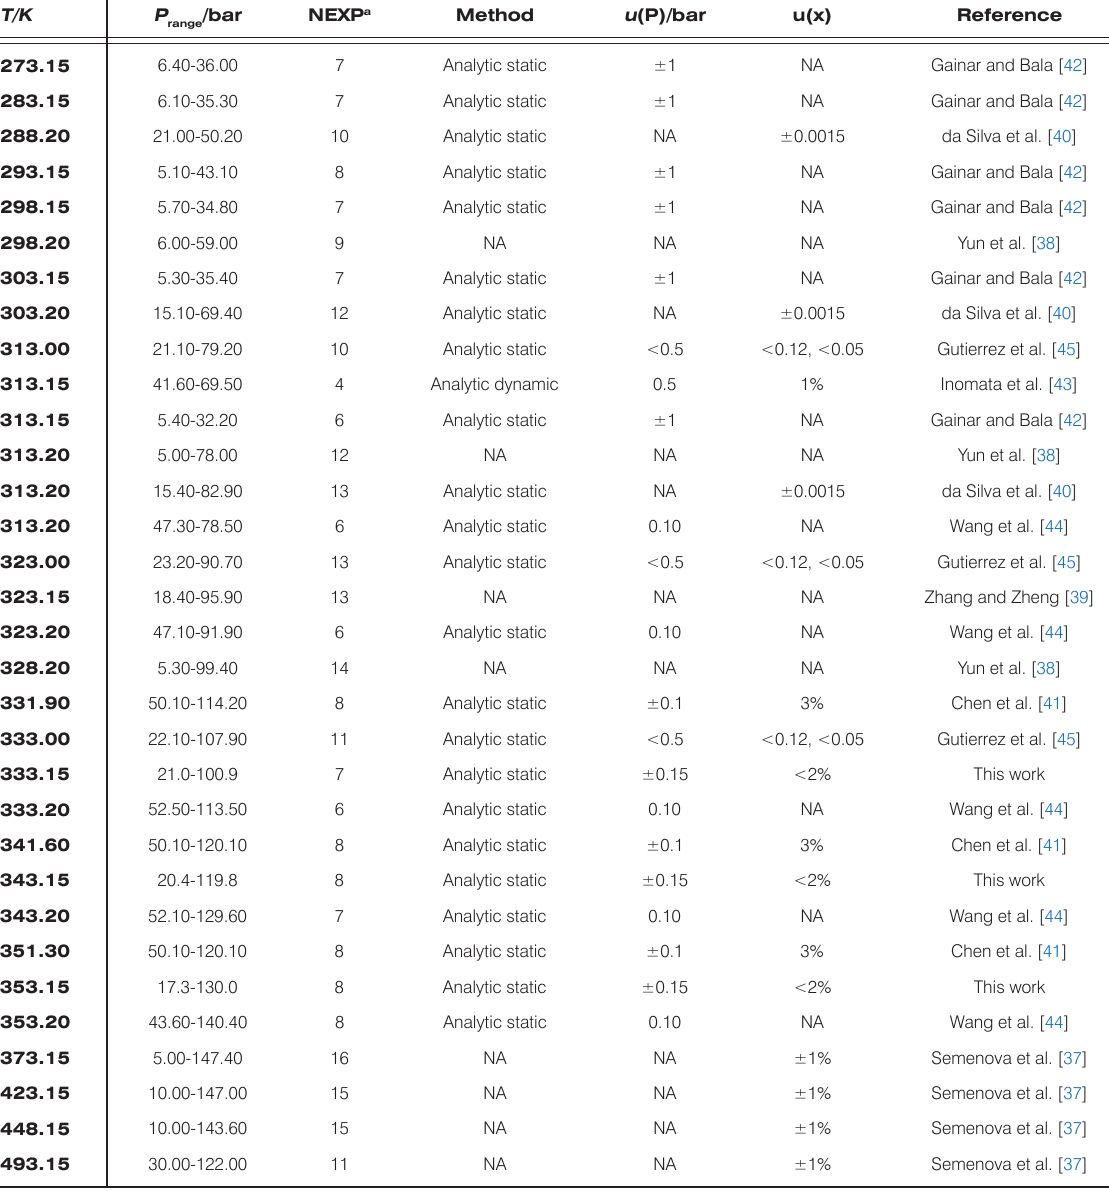
Table 1. Literature VLE experimental data for the carbon dioxide + 2-methyl-1-propanol binary